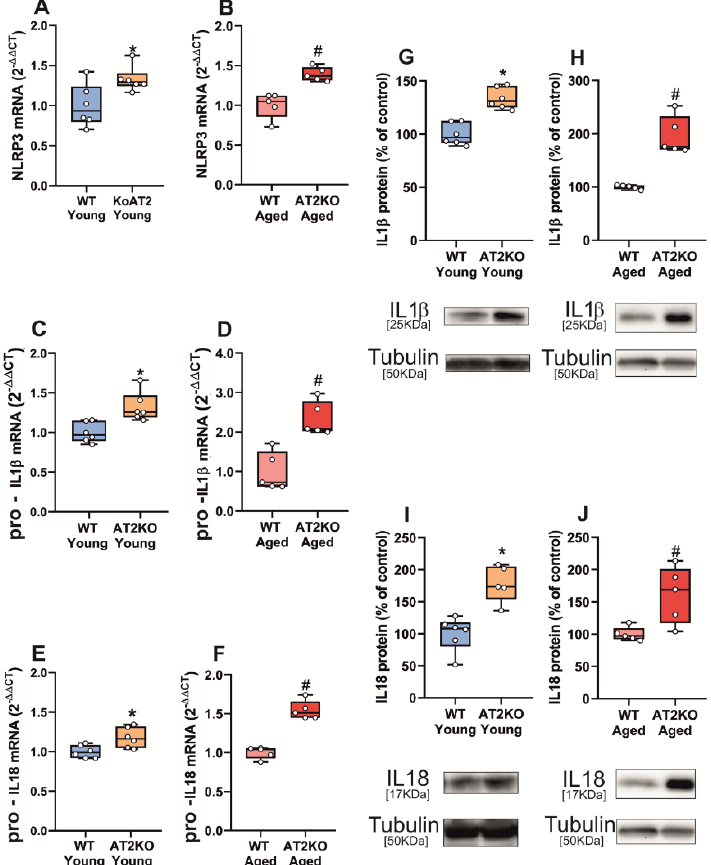
Figure 3. qRT-PCR and WB analysis of NLRP3 inflammasome markers in substantia nigra of WT and AT2 KO mice. mRNA expression of NLRP3, pro-IL1 β and pro-IL18 inflammasome markers significantly increased in young AT2 KO mice vs. young WT mice ( A , C , E ) and in aged AT2 KO mice vs. aged WT mice ( B , D , F ). Protein expression of IL1 β and IL18 significantly increased in young AT2 KO mice vs. young WT mice ( G , I ) and in aged AT2 KO mice vs. aged WT mice ( H , J ). To determine the relative mRNA expression of each gene of interest vs. the β -Actin housekeeping transcripts, we used the comparative Ct values method (2 − ∆∆ Ct ). Protein expression was determined relative to the α -tubulin band value and normalized to the control values (100%). Data distribution is shown using box plots with boxes representing the Interquartile range (IQR) and the median and whiskers representing the maximum value (upper whisker) and the minimum (lower whisker). * p <0.05 relative to young WT mice; # p < 0.05 relative to aged WT mice.